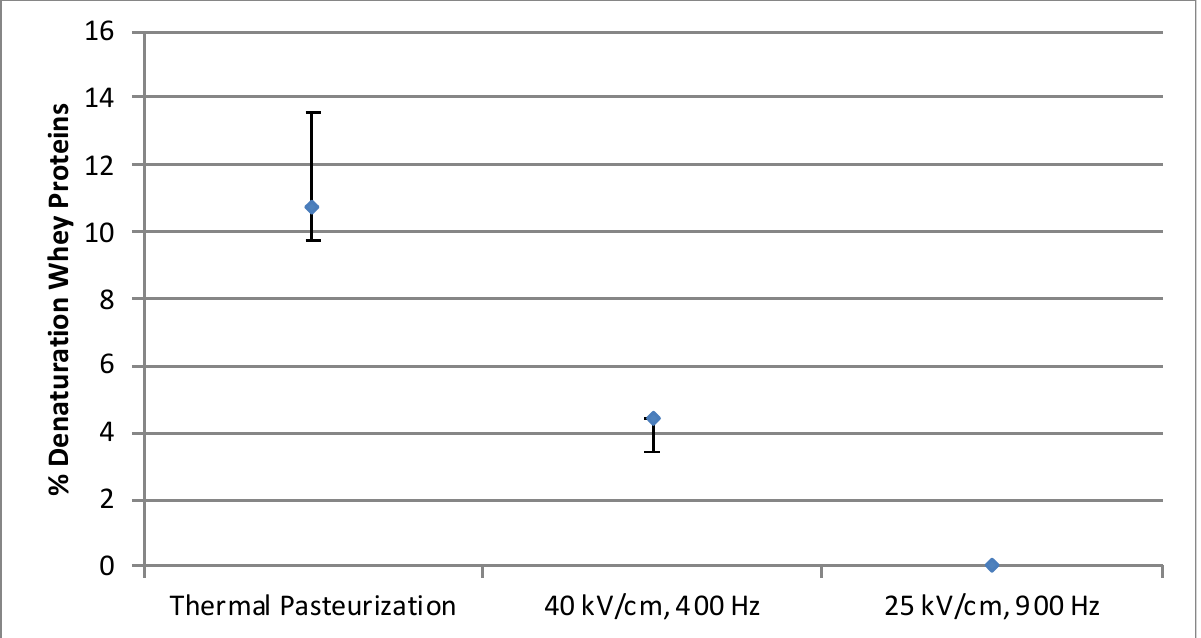
Figure 9. Percentage of whey protein denaturation after the pulsed electric field treatment and heat treatment. Mean results of duplicate experiments are presented. Error bars show the standard deviations of the data obtained.